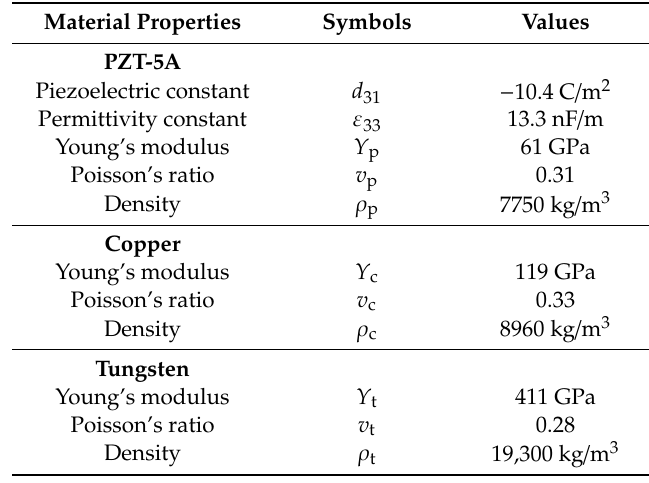
Table 2. Material properties of the